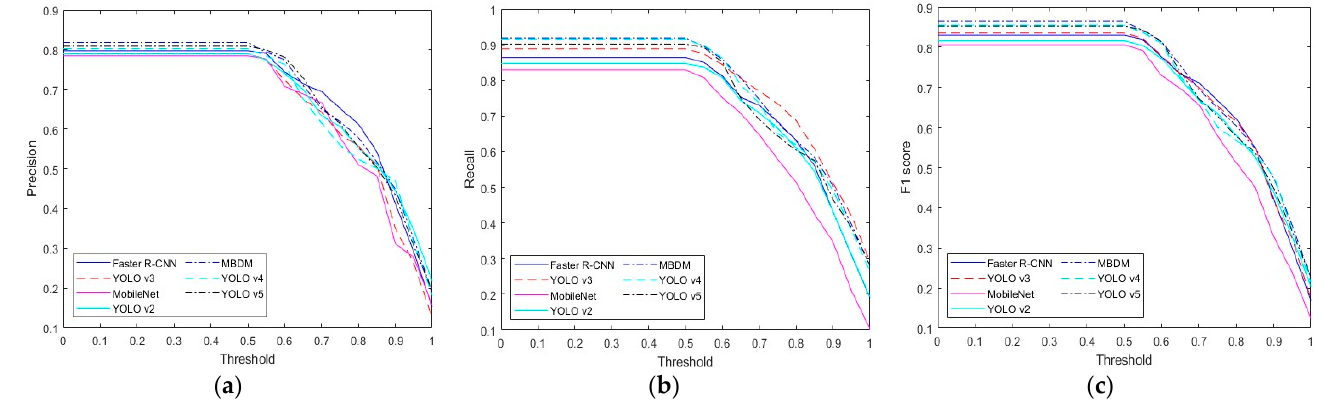
Figure 10. Performance comparison graph for each method according to IoU threshold in KRW da- tabase: ( a ) precision, ( b ) recall, and ( c ) F1 score.